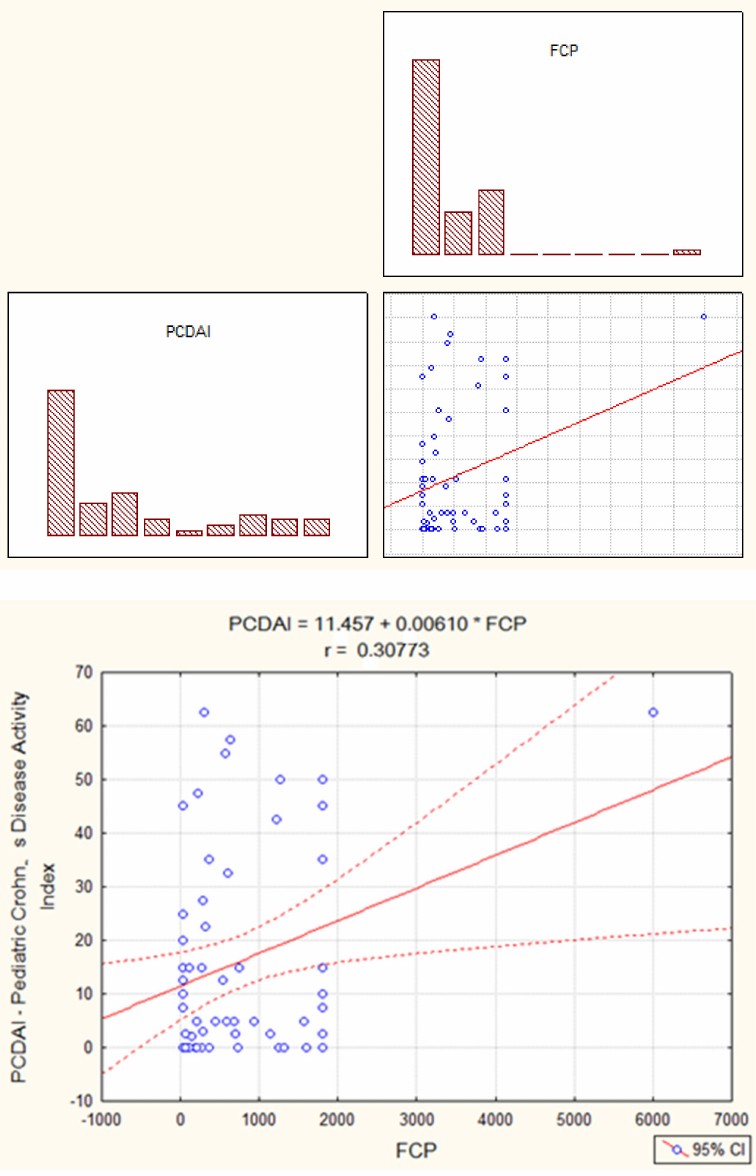
Figure 1. The level of FCP and clinical disease activity (PCDAI) of 57 patients included in the study; the higher the PCDAI score (more active disease), the higher the FCP level (r-Pearson: 0.31, r-spearman–0.186,